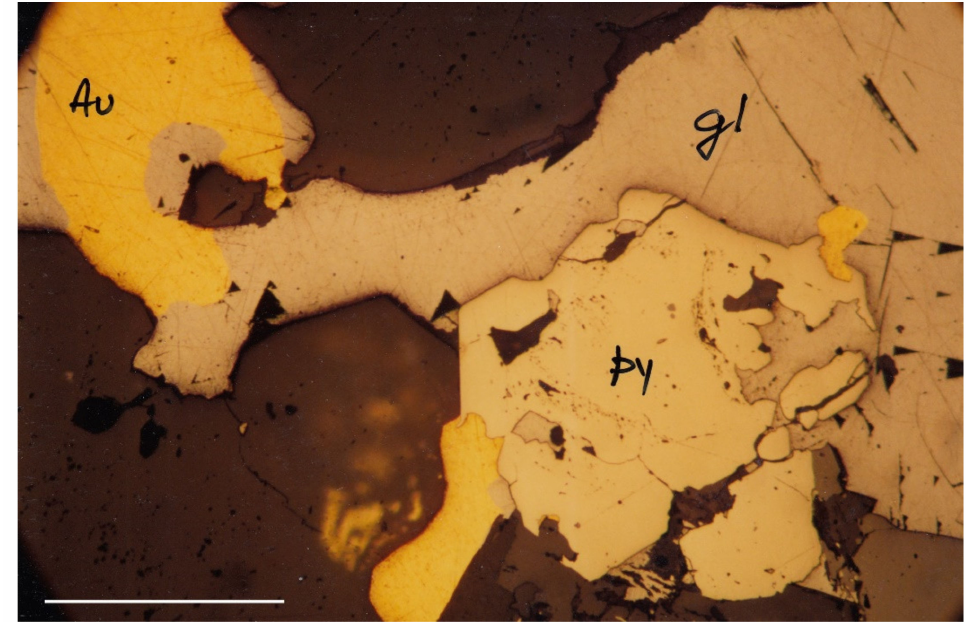
Figure 8. Strongly LV material from MIN1 comprising coarse gold grains associated with galena (gl) and pyrite (py). Field of view: 1.5 mm; Scale bar: 0.375